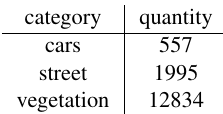
Table 1: Number of training candidates for the evaluation of the mean value